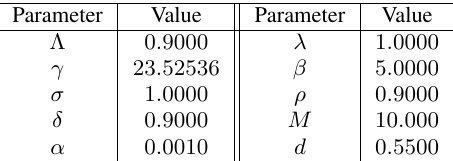
P ARAMETER VALUES USED IN F IGURE